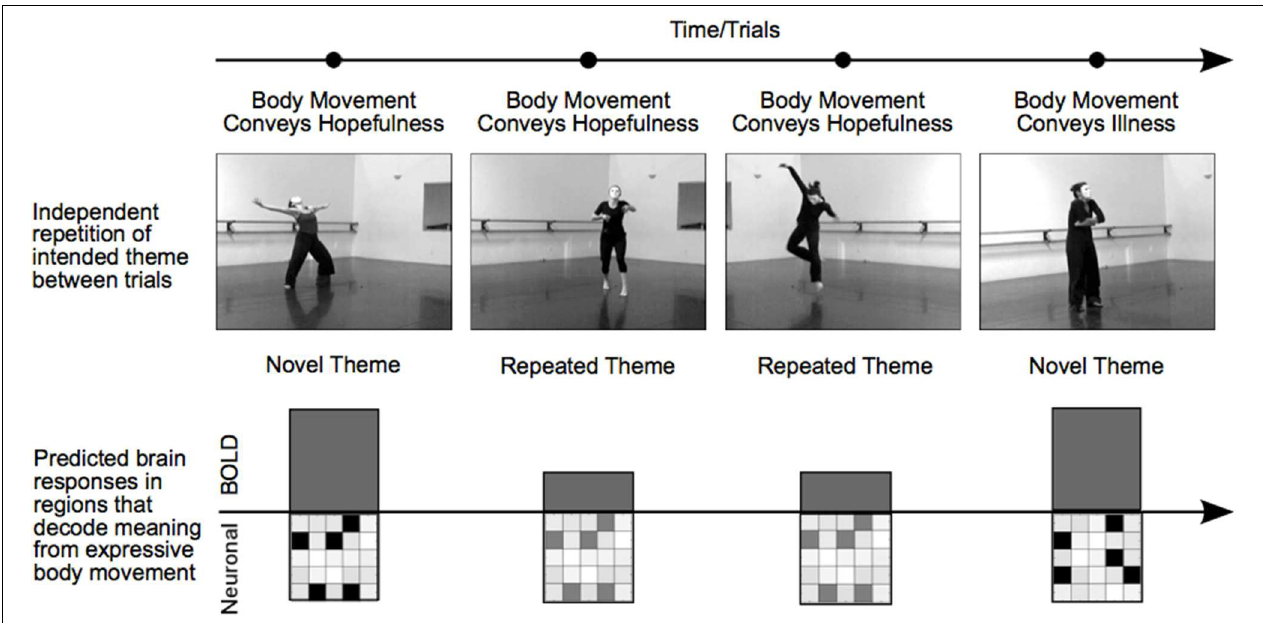
example—will evoke a particular pattern of neural activity. A novel theme on the subsequent trial—illness, for instance—will trigger a different but equally strong pattern of neural activity in distinct cell assemblies, resulting in an equivalent BOLD response. In contrast, a repetition of the hopefulness theme on the subsequent trial will trigger activity in the same neural assemblies as the first trial, but to a lesser extent, resulting in a reduced BOLD response for repeated themes. In this way, regions showing RS reveal regions that support distinct patterns of neural activity in response to different